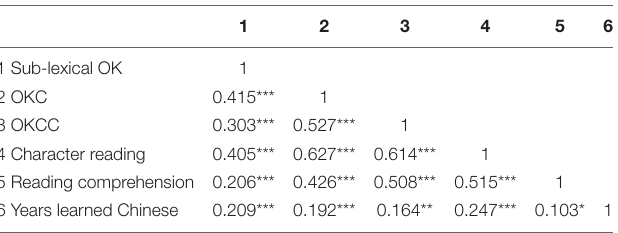
TABLE 2 | Partial correlation between performances of four tasks after controlling age